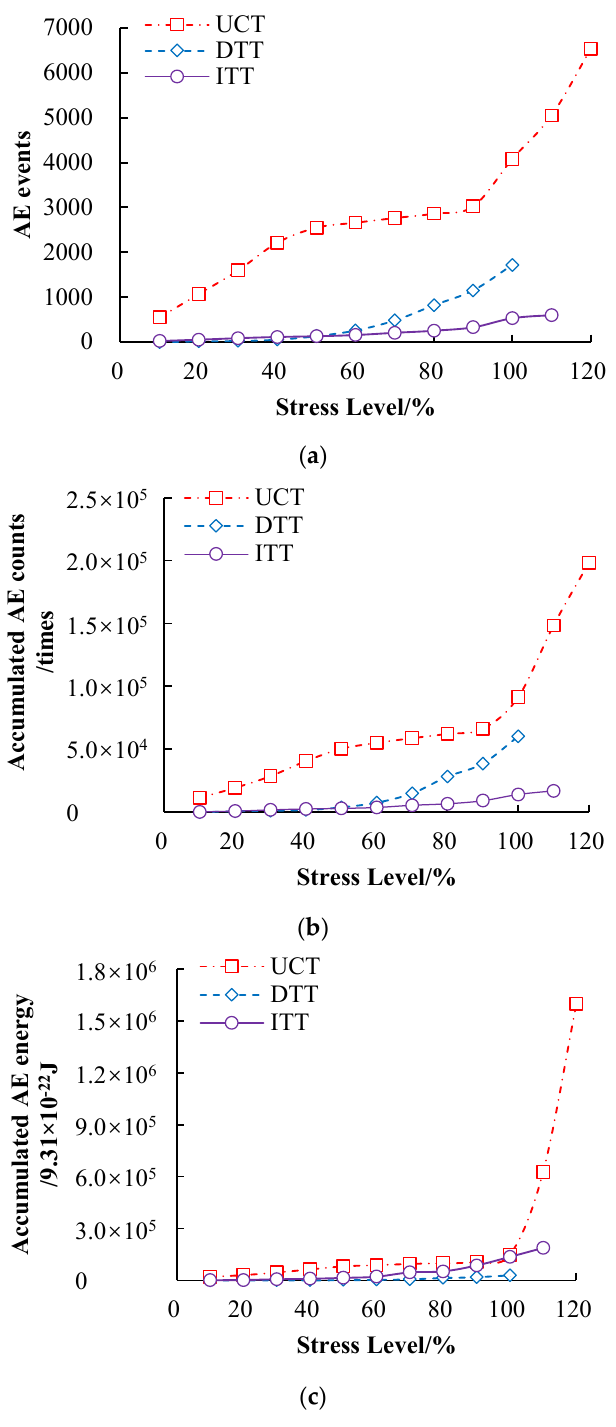
Figure 4. Average values of AE parameters of the marble samples under different loading modes: ( a ) AE events, ( b ) AE counts, ( c ) AE energy.